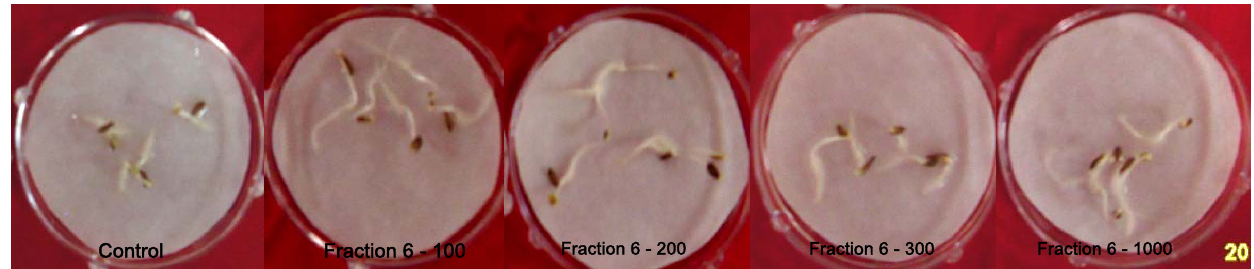
Figure 3. Effect of various concentrations (100, 200, 300 and 1,000 ppm) of fraction